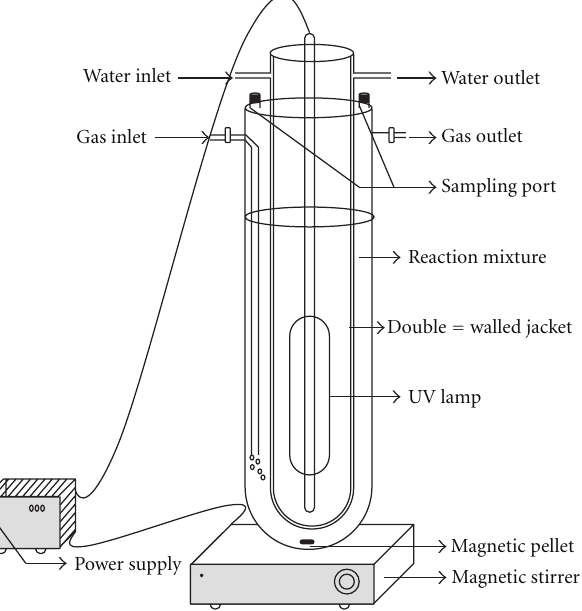
Figure 1: Schematic representation of photoreactor.